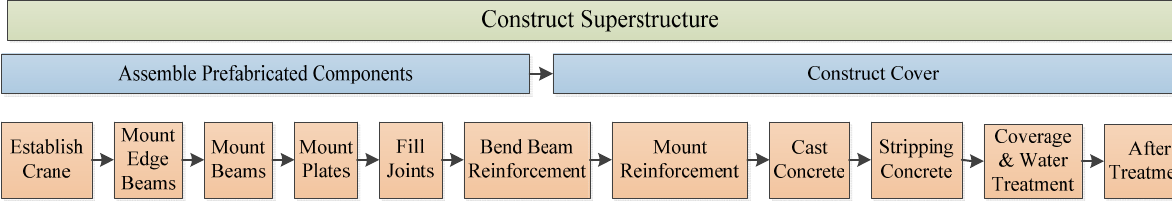
Figure 2. Construction process of the bridge superstructure.